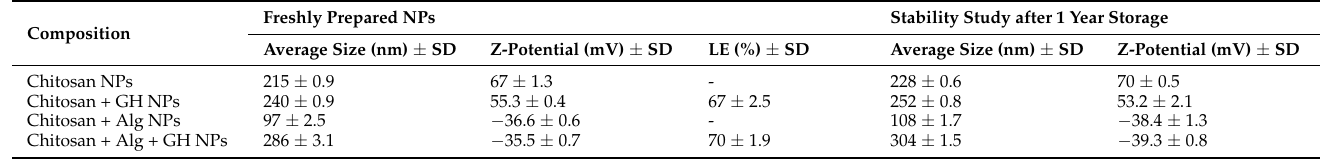
Table 1. Average particle size (nm), Z-potential, and LE (%) values of the different